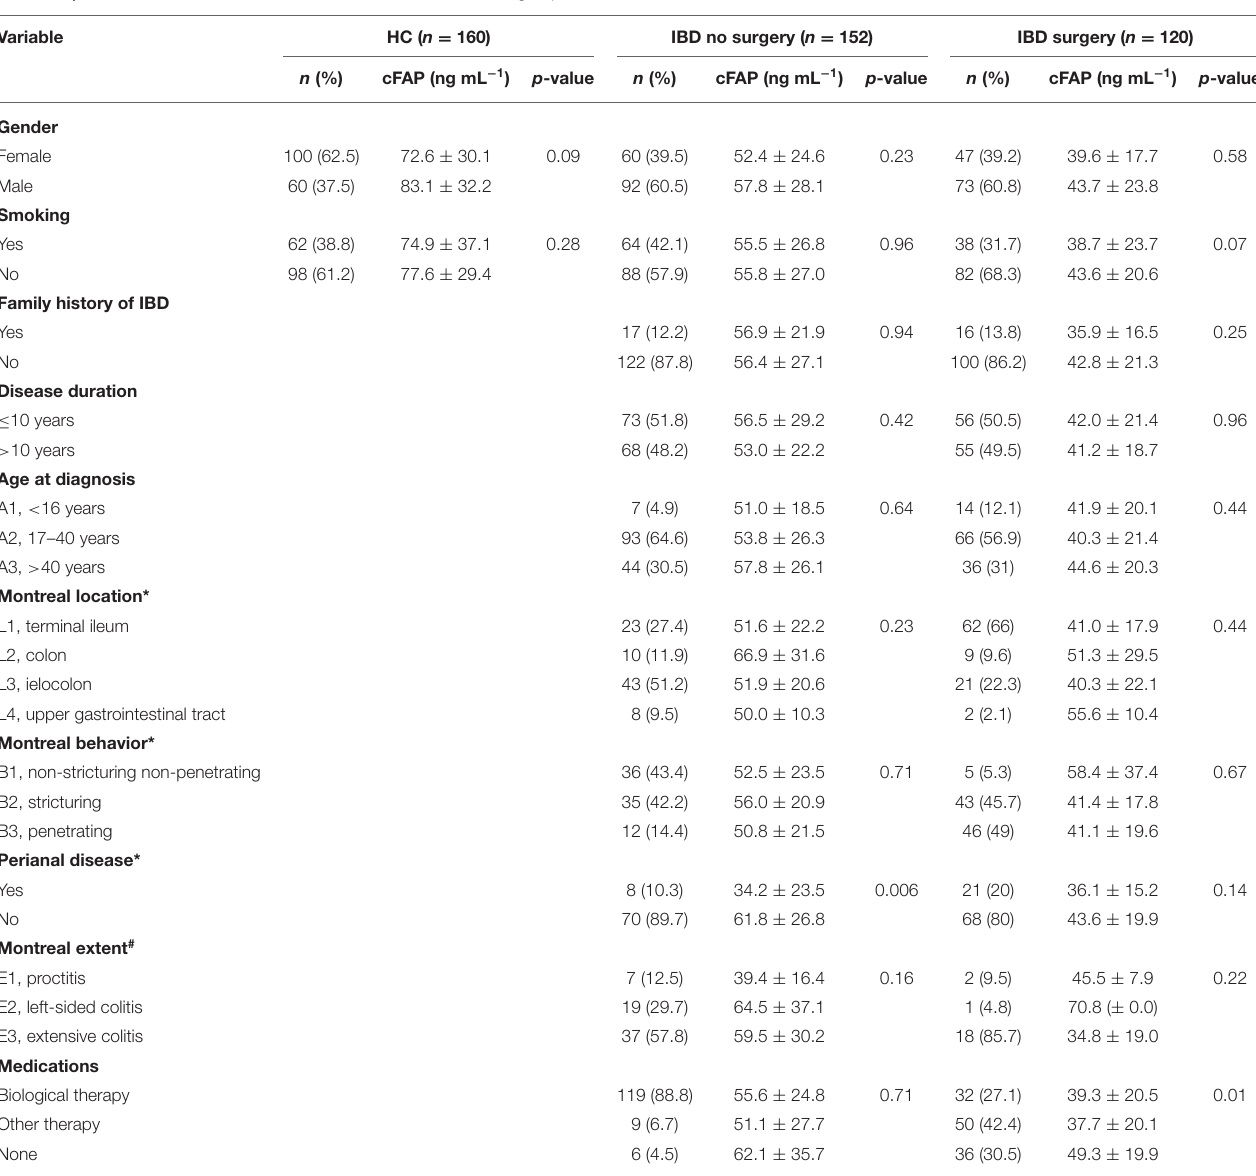
TABLE 2 | Baseline characteristics and levels of cFAP in HC and IBD groups.